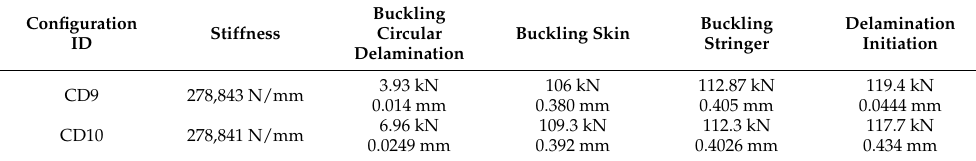
Table 5. Buckling loads and displacements for CD9 – CD10 configurations.